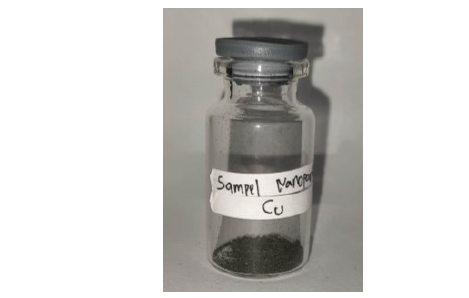
Fig. 5. Product of copper oxide nanoparticles